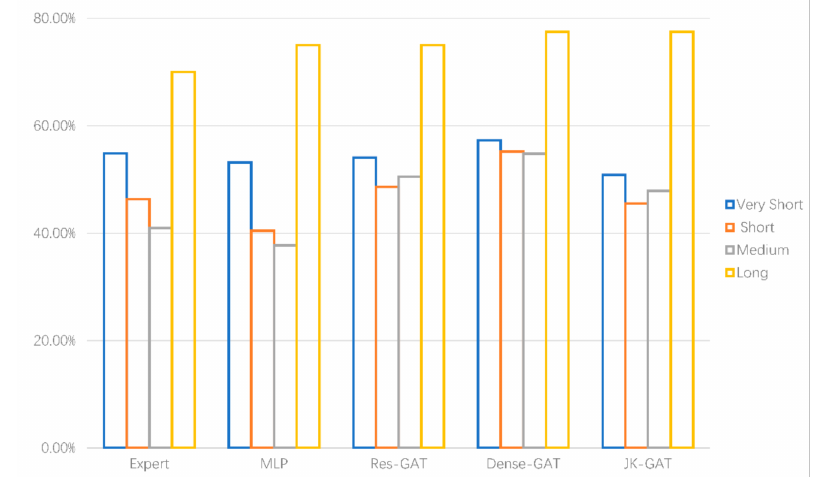
Figure 13. Histogram of selection rate of each length group for different